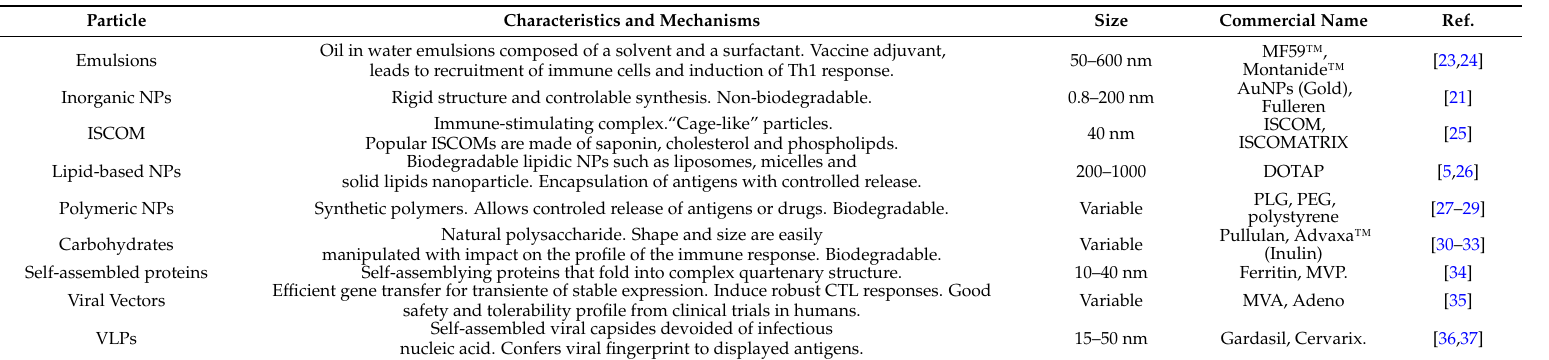
Table 1. General classes of nanoparticles